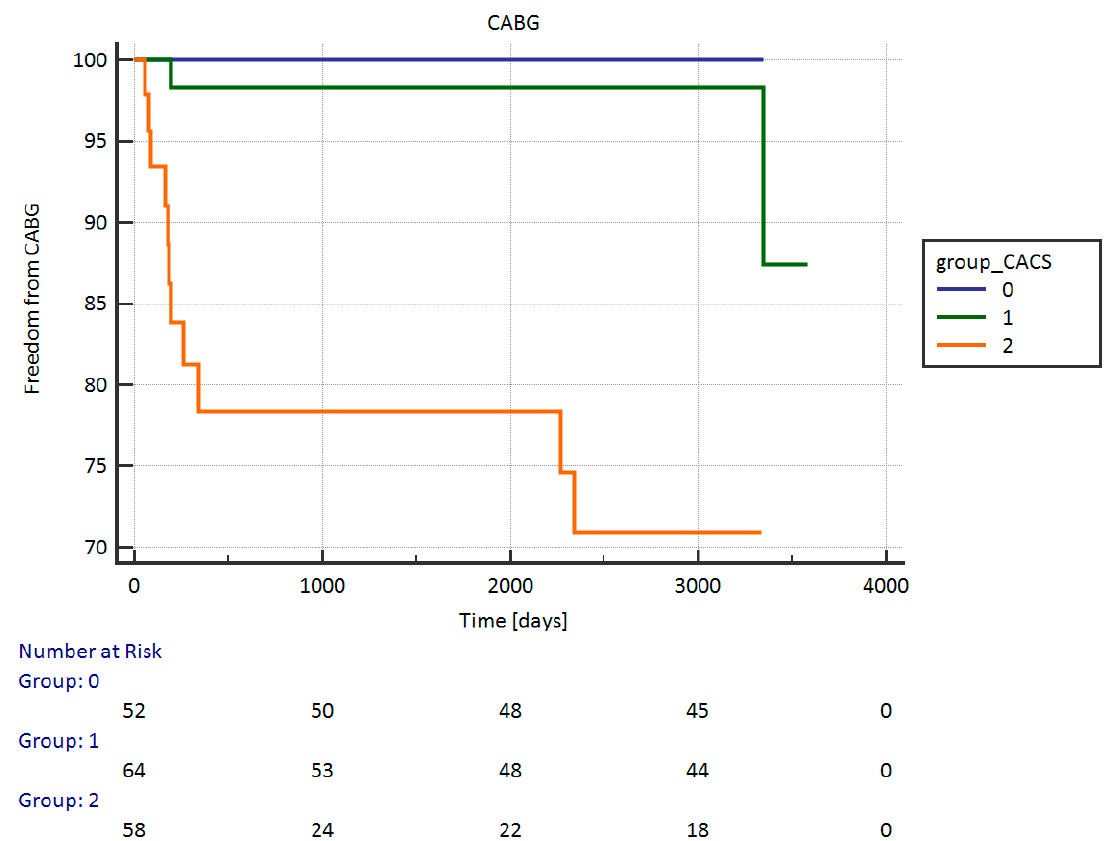
Figure 5. Event-free from CABG survival between patients with groups according to the CACS results. CABG: coronary artery bypass surgery.